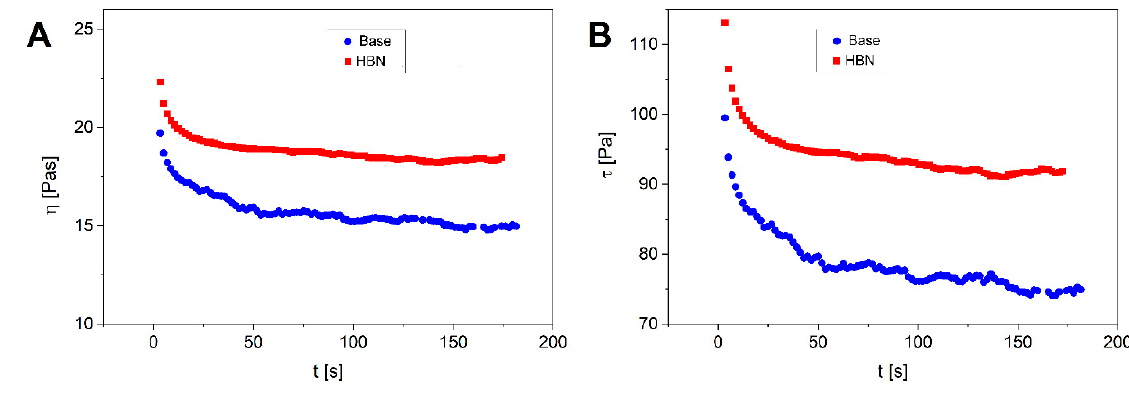
Figure 5. Viscosity ( A ) and shear stress ( B ) of the HBN and base formulation over time at a constant shear rate of 5 Pa. Error bars were always lower than 10%. The error bars are omitted for clarity purposes.